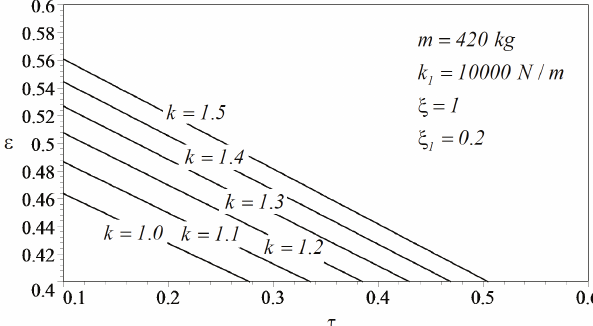
Figure 8. " versus (cid:28) , for different k for (cid:24) 1 D 0:2 to have near flat ride with ideal nonlinear damping.